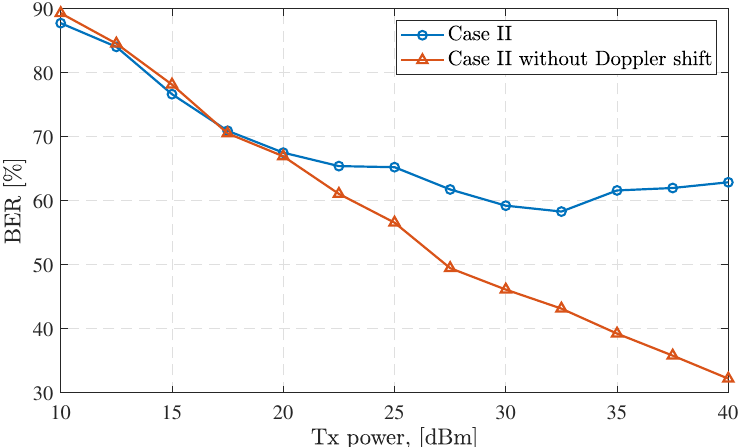
Figure 8. Comparison of the uplink BER varying with transmit power for case II with and without the Doppler shift.